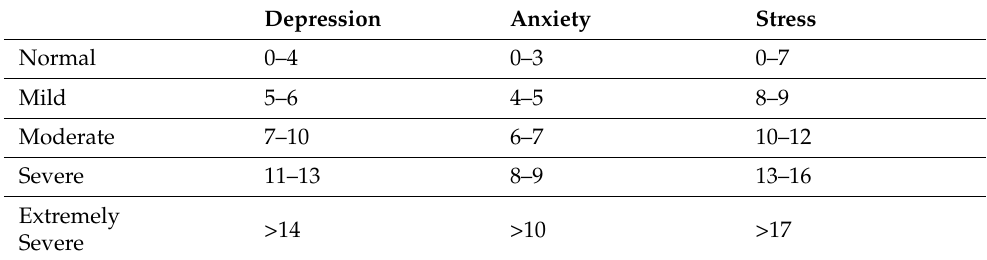
Table 8. DASS-21 Scores [5].